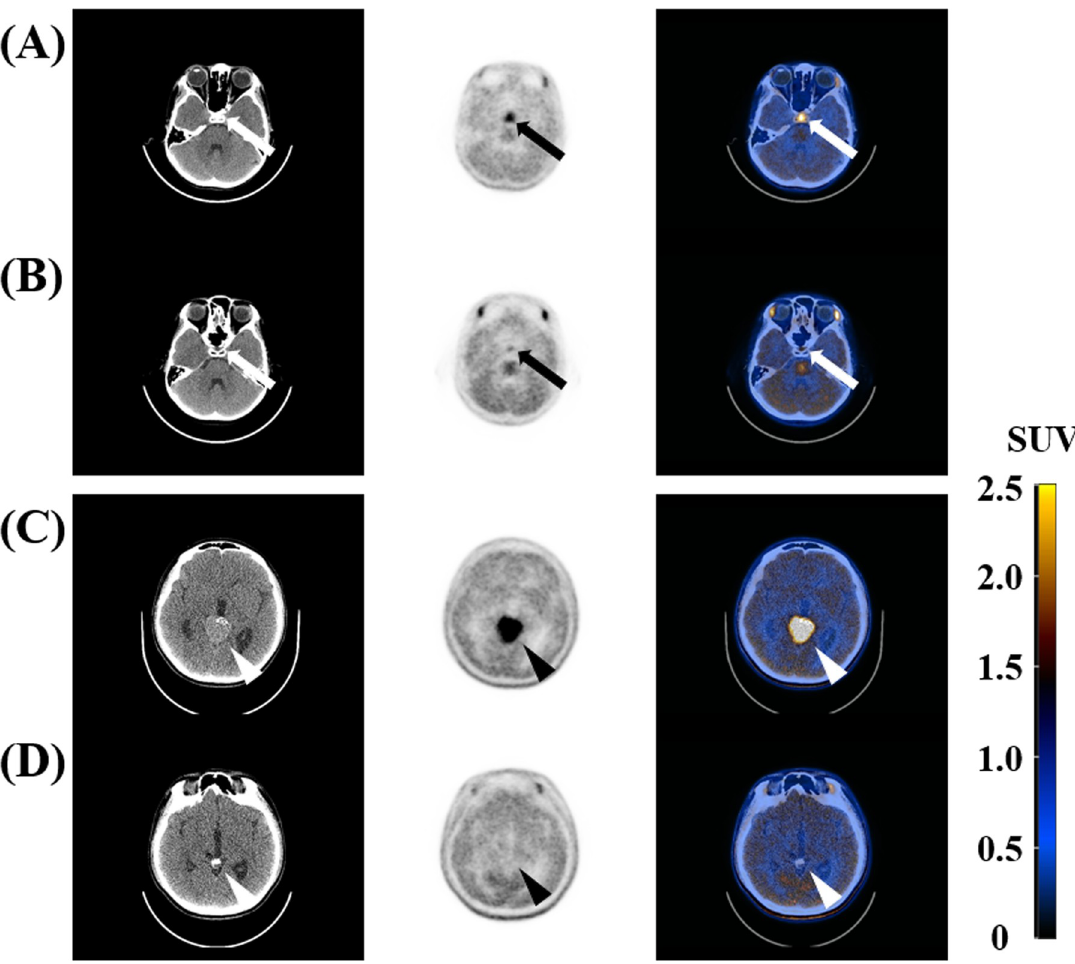
Fig 2. Non-contrast CT, MET PET, and fusion images of two representative cases in patients with IG before and after treatment. (A, B) The first case was an 11-year-old boy, and the patient experienced headache, polydipsia, polyuria, and growth hormone deficiency before treatment. The primary tumor was located in the sellar-suprasellar region (white and black arrows). Before treatment, pre-Tx SUV max and pre-Tx T/N ratio were 4.91 and 4.38, respectively. After chemotherapy and radiation therapy, post-Tx SUV max and post-Tx T/N ratio decreased to 1.62 and 1.27, respectively. The visual grade was three before the treatment and decreased to two after treatment. (C, D) The second case was a 14-year-old boy who experienced headache before treatment. The primary tumor was located in the pineal region (white and black arrow heads). Before treatment, pre-Tx SUV max and pre-Tx T/N ratio were 4.95 and 3.96, respectively. After chemotherapy and radiation therapy, post-Tx SUV max and post-Tx T/N ratio decreased to 1.52 and 1.15, respectively. The visual grade was three before treatment and then decreased to one after treatment. CT, computed tomography; MET, C-11 methionine; PET, positron emission tomography; IG, intracranial germinoma; pre-Tx, pre-treatment; SUV max , maximum standardized uptake value; T/N, tumor-to-normal tissue; post-Tx, post-treatment; SUV, standardized uptake value.